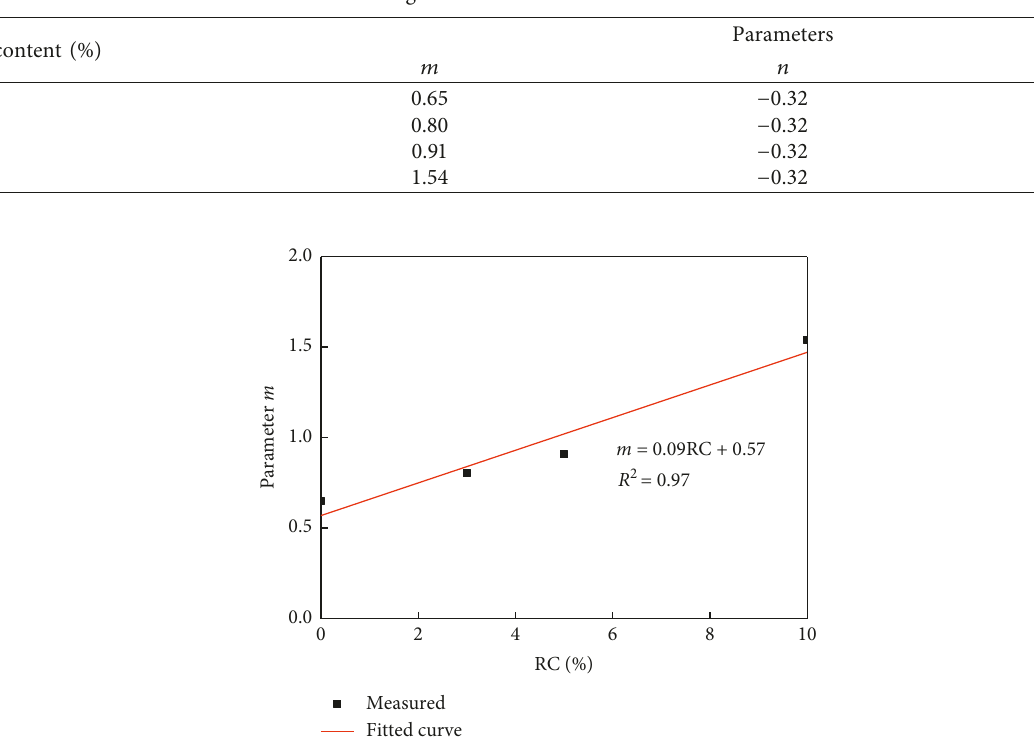
Figure 11: Relationship between CSR and Nf for different rubber contents (a) and for different effective confining pressures (b). Table 3: Fitting values of m and n for different test cases.